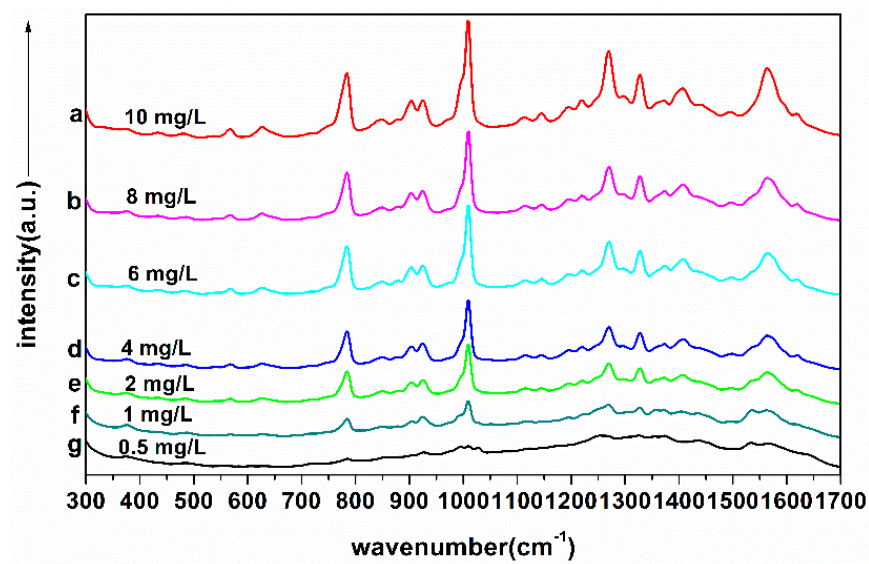
Figure 6. 300–1700 cm − 1 SERS spectra of seven different concentrations of TBZ in red soil extracts: ( a )